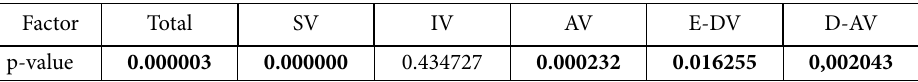
Table 6. Results of Mann–Whitney test: comparison of gender scores according to factors (source: own, 2018) Factor Total SV IV AV E-DV D-AV